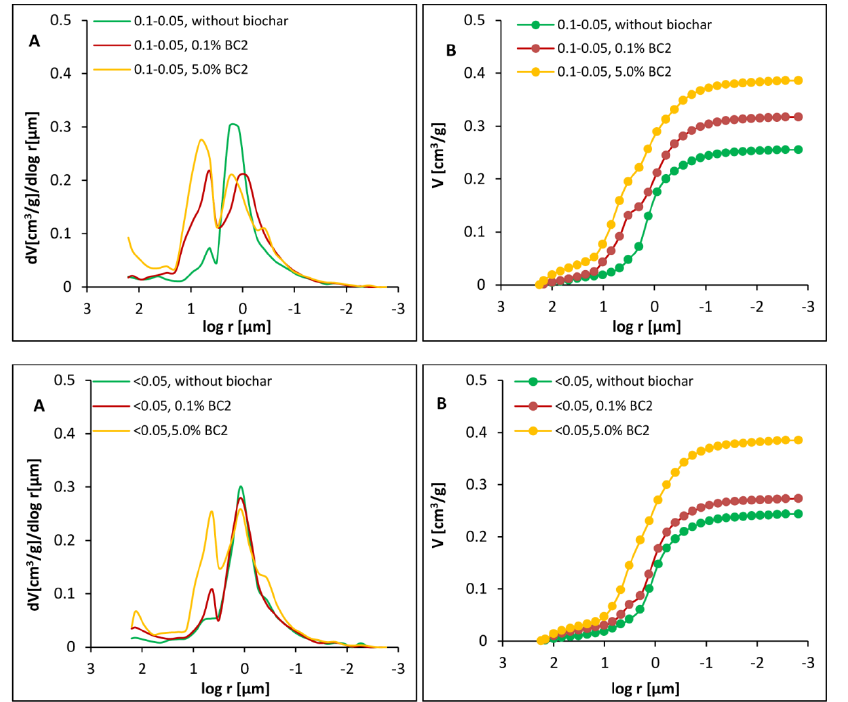
Figure 6. Differential ( A ) and cumulative ( B ) curves of pore volume vs. equivalent pore radius of cylinders remolded using selected Dystric Cambisol fractions with and without sunflower husk biochar; the curves were drawn based on the average value of three measurements.